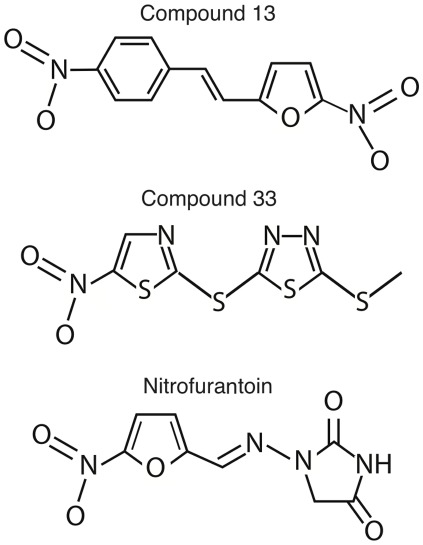
Small molecule structures.The chemical names of compounds 13 and 33 are 2-nitro-5-(4-nitroStyryl)furan (MW = 260.20) and 2-(methylthio)-5-[(5-nitro-1,3-thiazol-2-yl)thio]-1,3,4-thiadiazole (MW = 292.39) respectively.